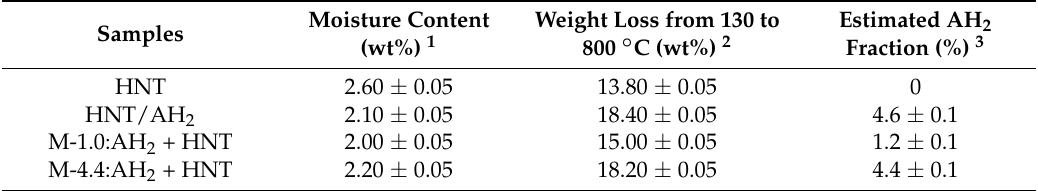
Table 1. TGA data of pristine (HNT) and modified (HNT/AH 2 ) halloysite, along with plain ascorbic acid (AH 2 ) and reference AH 2 + HNT physical mixtures.